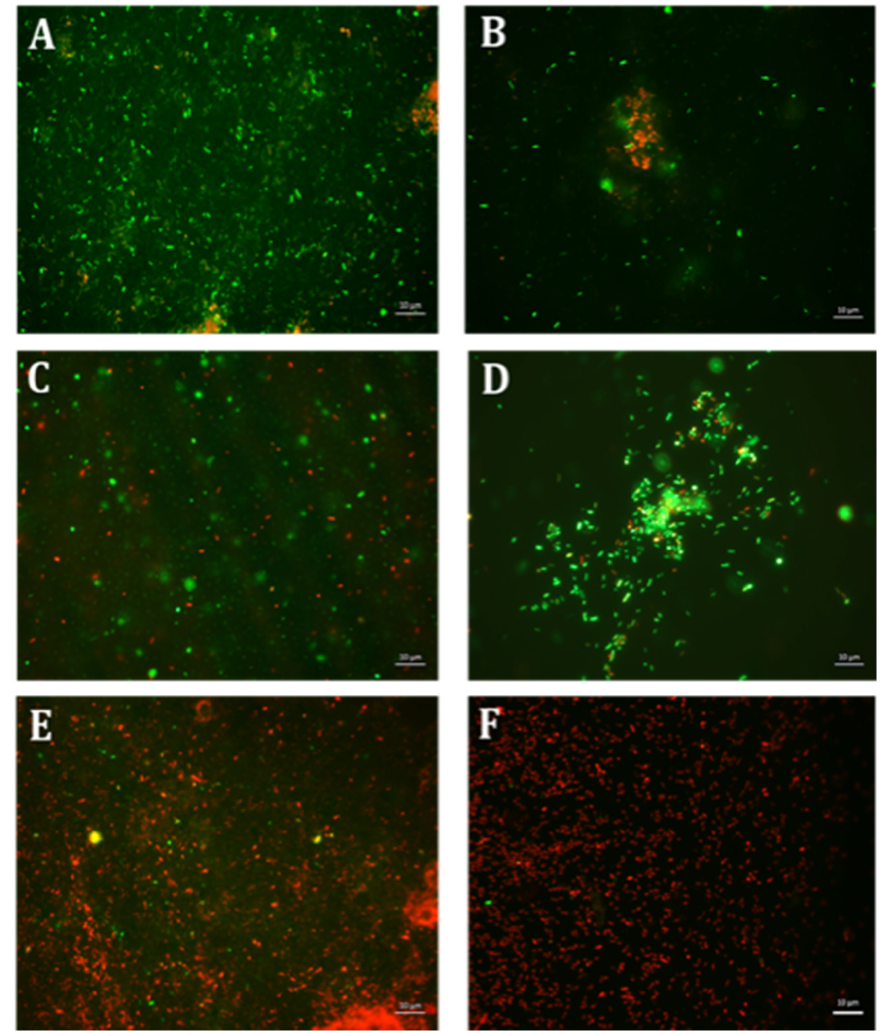
Figure 2. Fluorescence microscopic observation of cell viability on E. coli biofilm formation. E: erythromycin; ES: EGCG-S. Scale bar = 10 μ m. ( A ) Control, ( B ) E10, ( C ) E15, ( D ) ES50, ( E ) E10+ES150, and ( F ) E10+ES200. The results indicated that both E10+ES150 and E10+ES200 severely affect the integrity of the cells and E10+ES200 is the most effective Table 2. Colony-forming units (CFU/mL) and respective log reduction and percentage of inhibition for different treatments on biofilm formation in M. smegmatis . E: erythromycin; ES: EGCG-S.